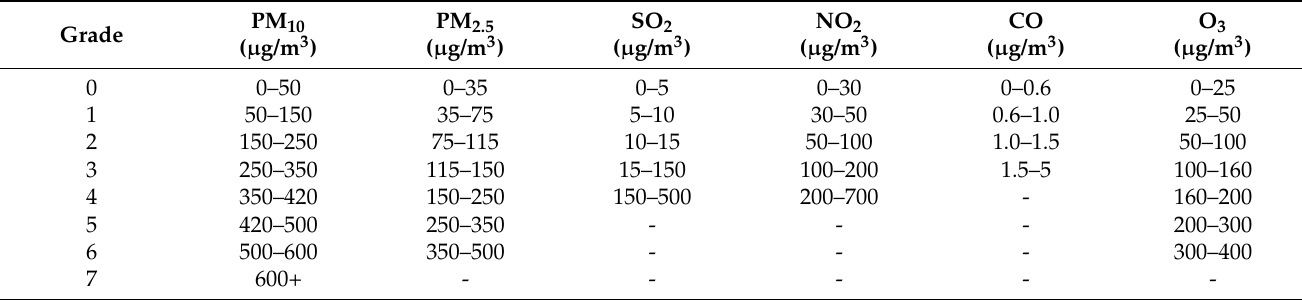
Table 4. Air pollutant concentration value interval division after redivision.